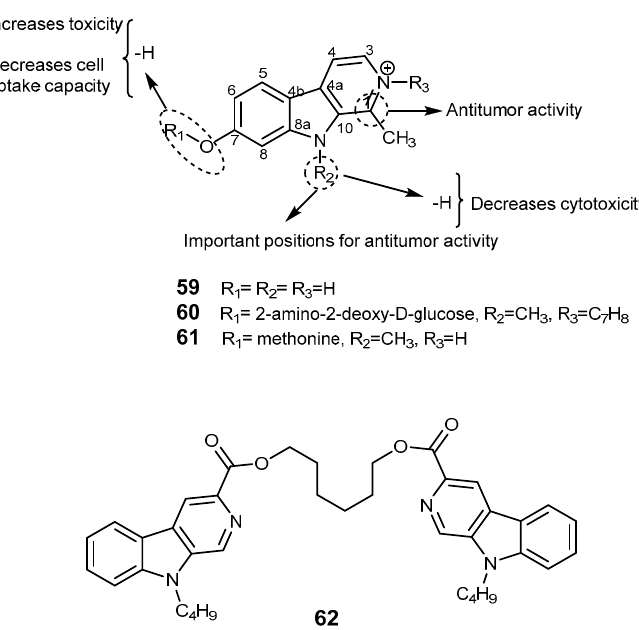
Figure 11. Harmine ( 59 ) and analogs 60 – 62 . The dashed circles indicate groups important for biological functions.